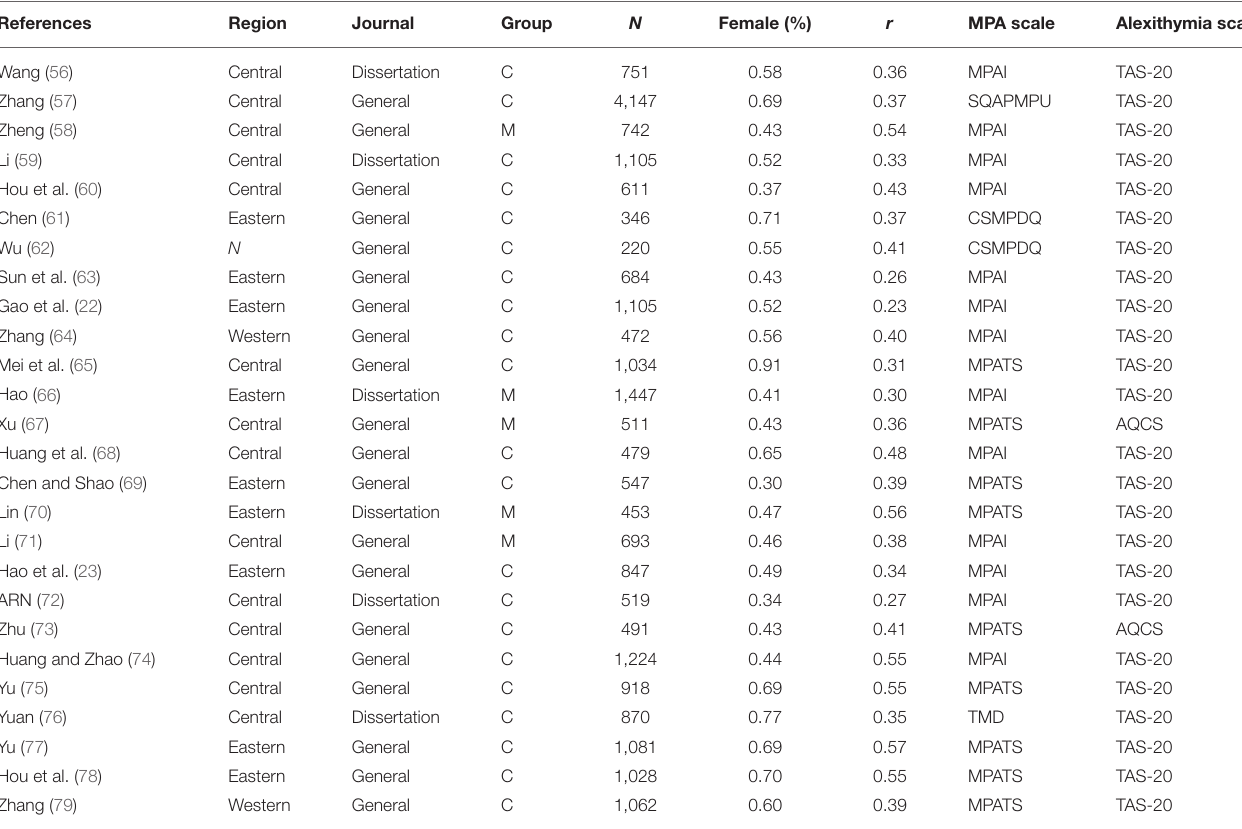
TABLE 1 | Characteristics of the 26 studies included in the meta-analysis.